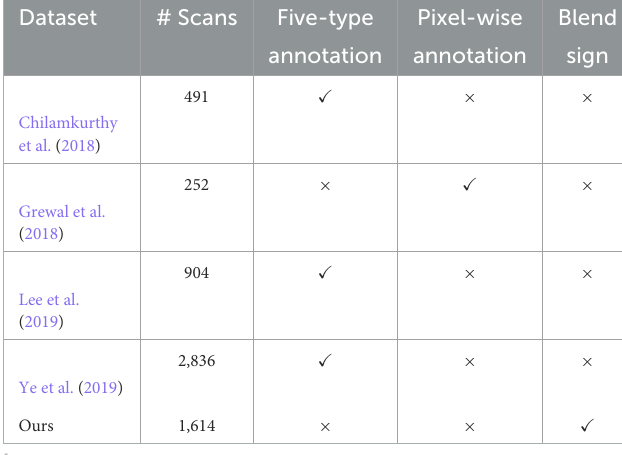
TABLE 1 Comparison with other related datasets for the detection of intracranial